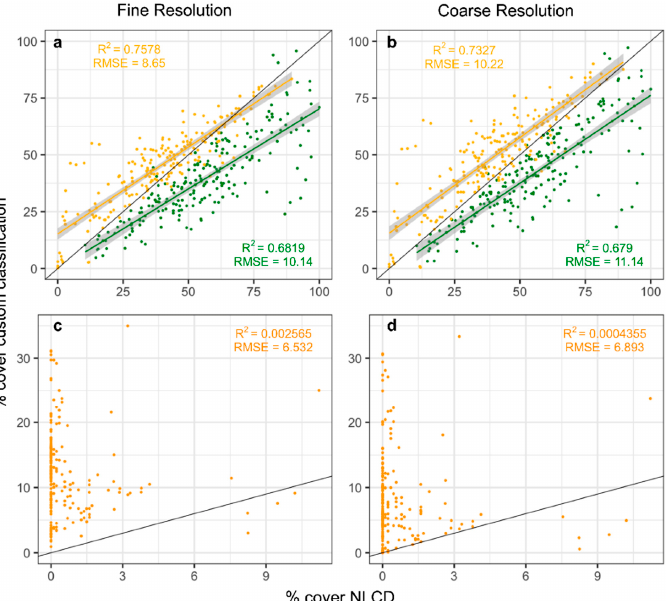
Figure 5. Relationship between percent cover of vegetation types within a 500 m buffer around randomly selected points within areas known to have a mix of pasture/grassland and shrub/sapling cover in a forested matrix. Percent cover of the following vegetation cover types was calculated from National Land Cover Data (NLCD) and our custom classification: pasture (yellow, a , b ), forest (green, a , b ) and shrub/sapling (orange, c , d ). The black line represents a 1:1 correlation; points above this line are where NLCD under-represents the cover type relative to our custom classification and points below the line are where NLCD over-represents the cover type relative to our custom classification. 95% confidence intervals are represented by grey ribbons around the trend